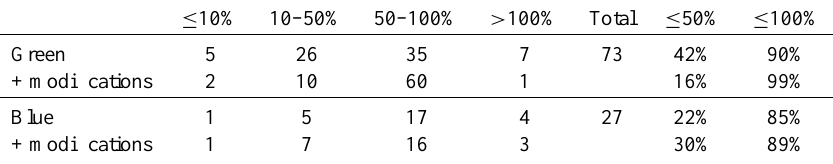
Table 1. Distribution of relative errors between the ESR and the ASC measurements of energy fluxes. In every second row the “+ modi- fications” refers to the results from the modified version of the ASC inversion. The last three columns are for the total number of inverted images for each emission line, and the percentage of the events for which the relative error is less than 50% and 100%, respectively. ≤